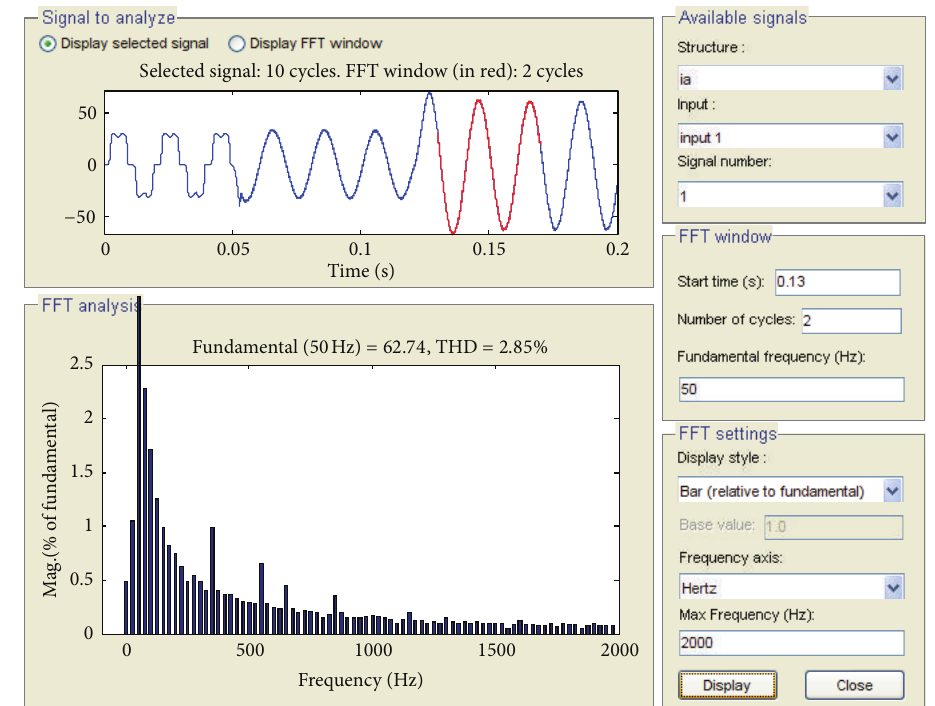
Figure 7: Current harmonic analysis from 0.13 to 0.17 second.